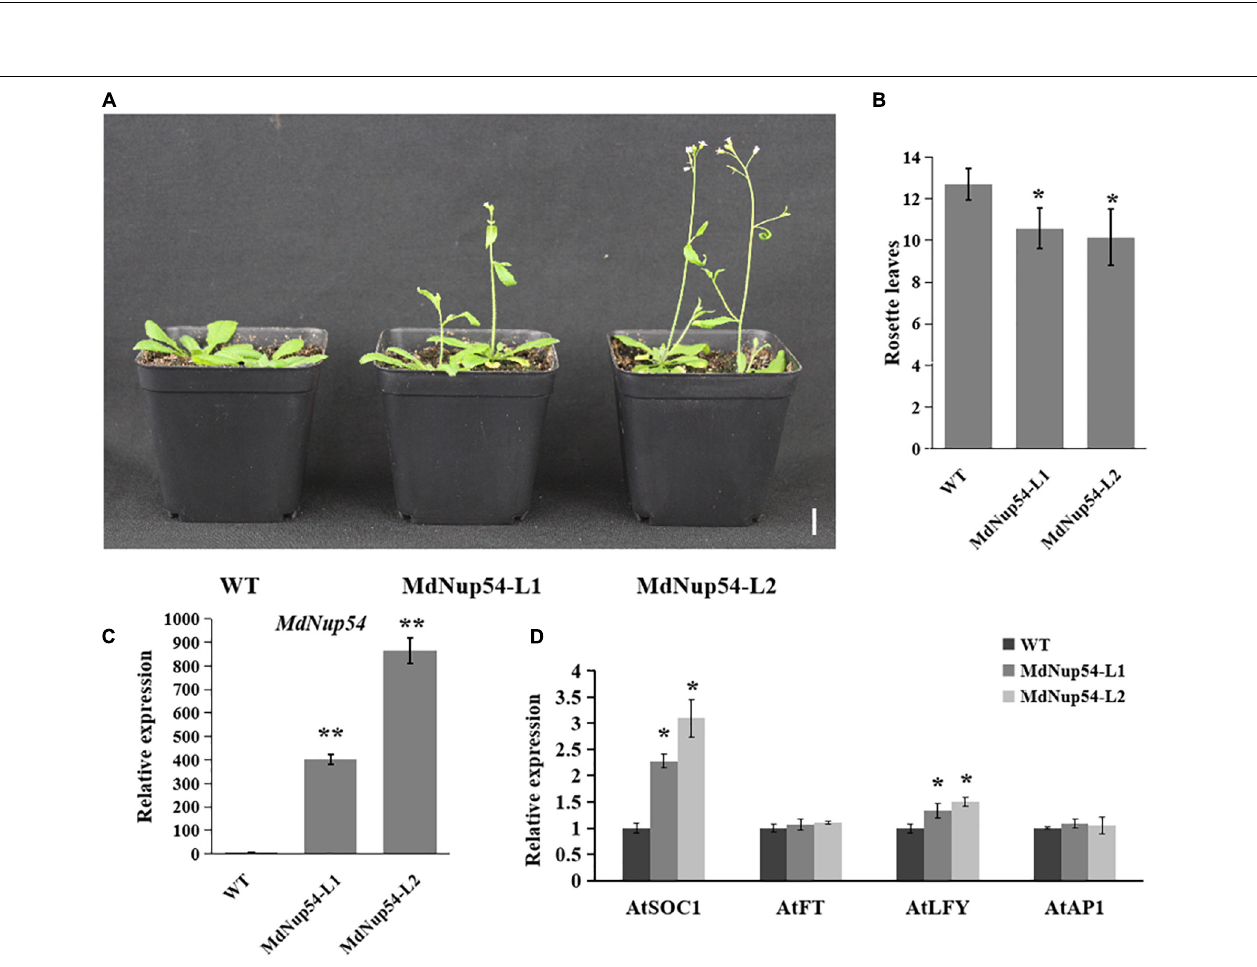
FIGURE 3 | MdNup54 promotes flowering in Arabidopsis. (A) Phenotype of the MdNup54 -OE Arabidopsis lines for flowering time. Bar = 2 cm. (B) Statistical analysis of rosette leaves of Arabidopsis thaliana during bolting ( n = 15 plants per line). (* P < 0.05). (C) qRT-PCR analysis of MdNup54 expression in Arabidopsis samples. (** P < 0.01). (D) Relative expression levels of flowering genes ( AtFT , AtLFY , AtSOC1 , and AtAP1 ) in WT and MdNup54 -OE lines. (* P < 0.05).